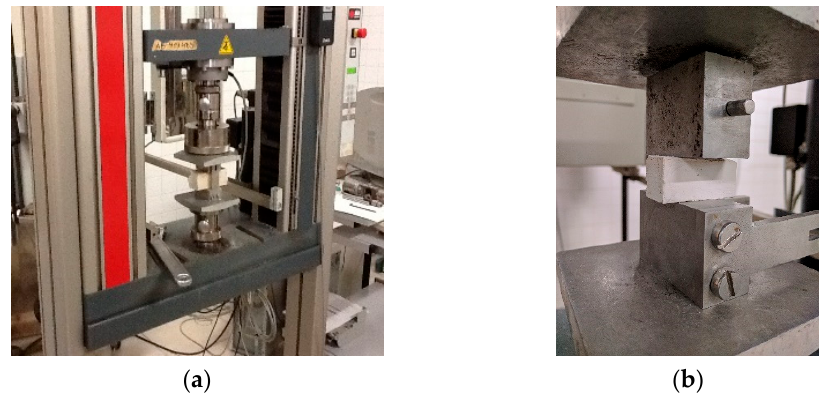
Figure 3. Set-up of the mechanical testing machine: ( a ) Mechanical test machine; ( b ) Compressive test.